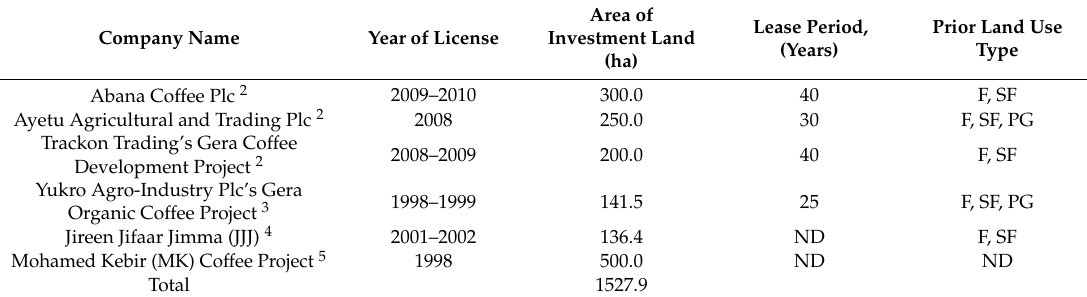
Table 1. Year of license, area of investment land, lease period and prior land use types for the land transferred to the private companies in the Gera district of Ethiopia 1